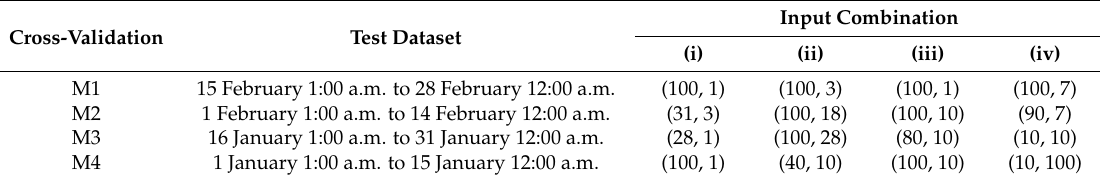
Table 6. Parameters of LSSVR for each input combination for wind power